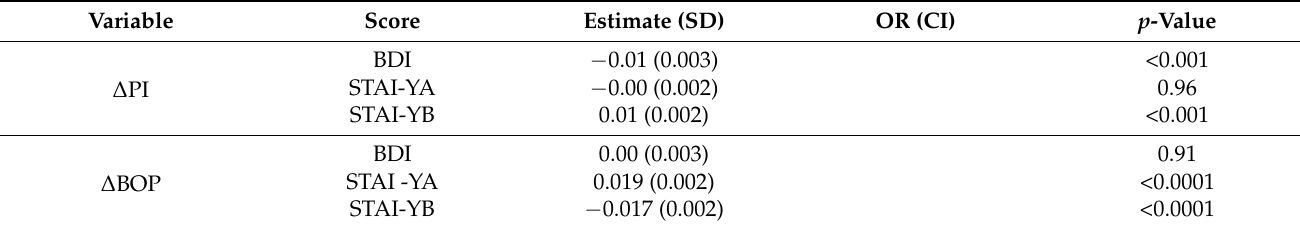
Figure 2. Evolution of periodontal parameters following SRP. PI, mean % of sites with BOP, mean PPD (mm), % of sites with PPD > 3 mm, >5 mm, 7 mm, mean CAL (mm), % sites with CAL > 3 mm, >5 mm, 7 mm were measured at baseline, 3 and 6 months. *: p < 0.05 vs. baseline. Table 1. Multivariate analysis of covariance between periodontal treatment outcomes and psychological scores. Associations were analyzed by linear and logistic mixed regression models considering psychological parameters at baseline and the evolution of periodontal parameters between baseline and 6 months. All potential influencing variables were considered (age, smoking, gender) in the mathematical model. Significant associations are in bold ( p < 0.05). ∆ PI, ∆ BOP, ∆ PPD and ∆ CAL represent the difference for mean PI, BOP, PPD and CAL between baseline and 6 months, respectively; ∆ PPD > 3 mm, ∆ PPD > 5 mm and ∆ PPD > 7 mm represent the difference for number of sites with PPD > 3 mm, >5 mm and 7 mm between baseline and 6 months. ∆ CAL > 3 mm, ∆ CAL > 5 mm and ∆ CAL > 7 mm represent the difference for number of sites with PPD > 3 mm, >5 mm and 7 mm between baseline and 6